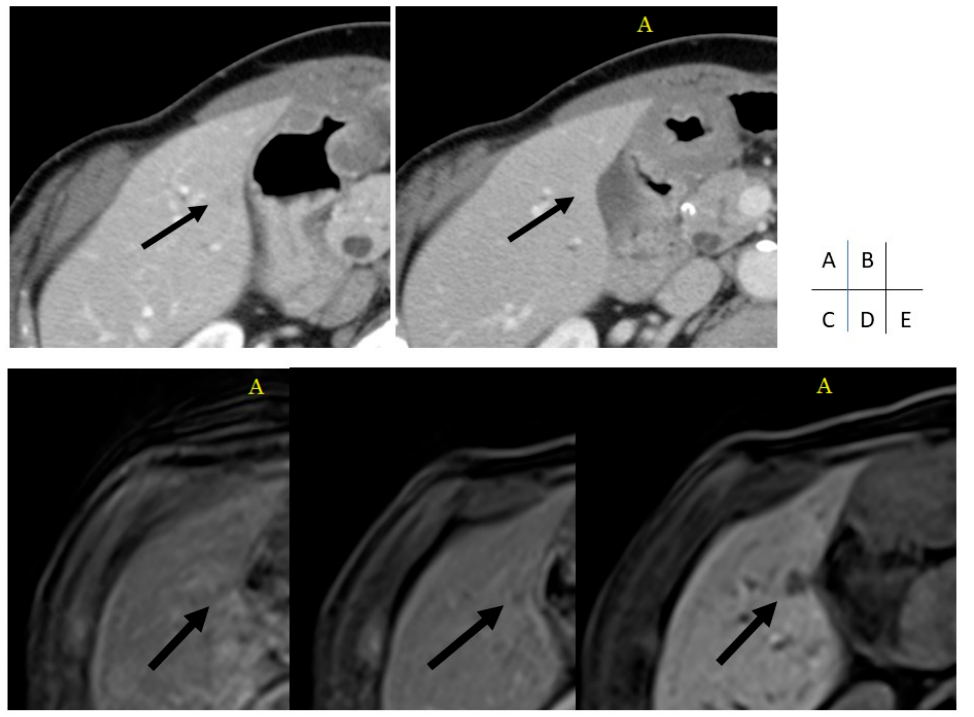
Figure 1. Images of CT and MRI examinations of a 74-year-old female patient with small metastasis of PDAC (A, arterial-phase CT; B, portal-venous phase CT; C, arterial-phase MRI; D, portal-venous phase MRI; E, hepatobiliary phase MRI). A small lesion in segment 5 (arrow) was only detected by the experienced readers, A and B, using MRI (only depicted by hepatobiliary phase MRI), but the lesion was missed by all readers using CT.